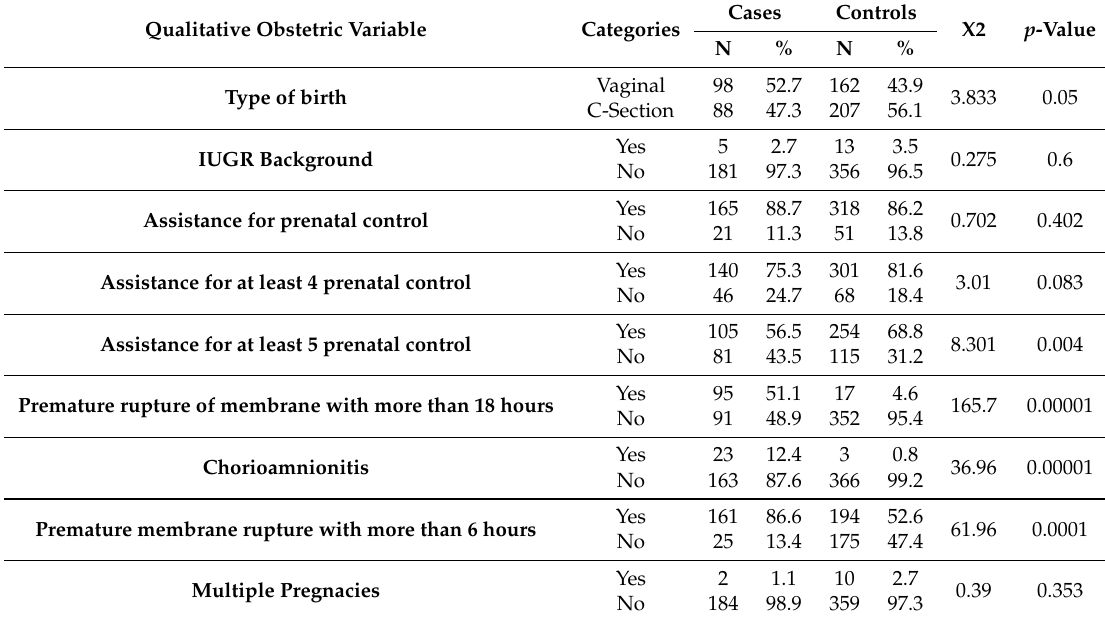
Table 9. Qualitative Obstetric variables in cases (186) and controls